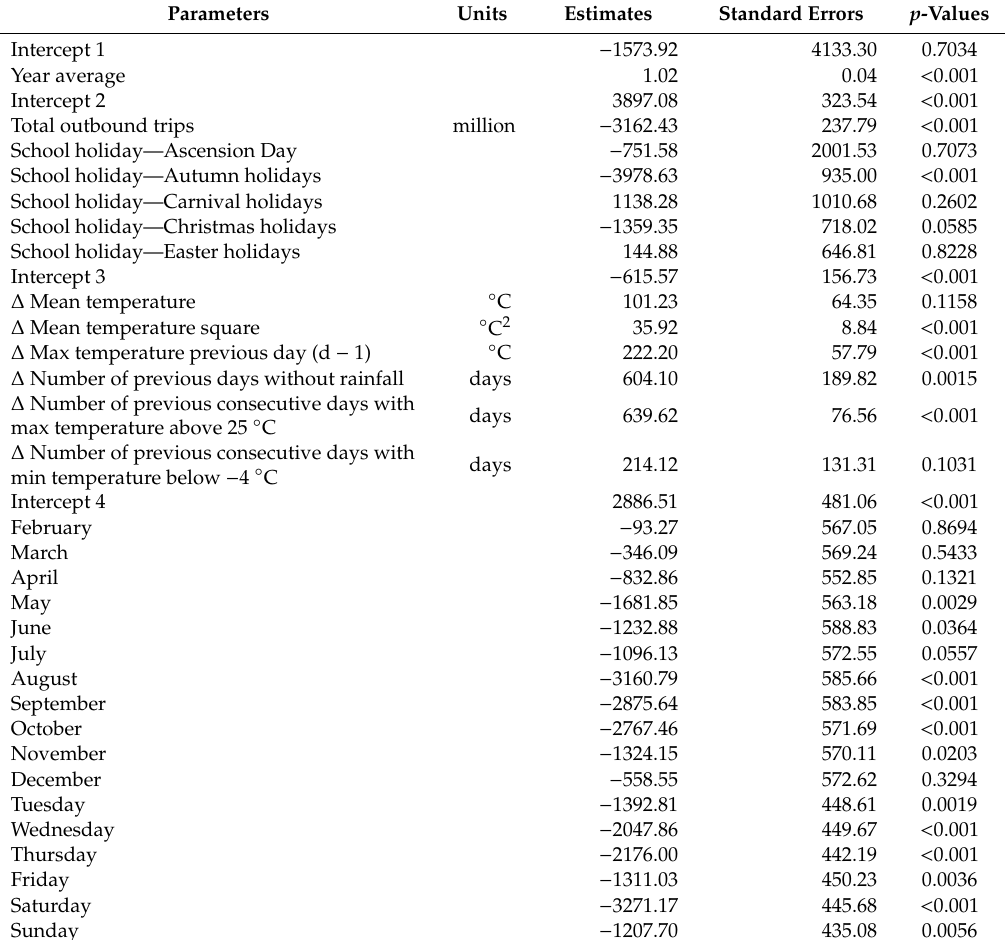
Table 1. Parameter estimates of the final model with their standard errors and